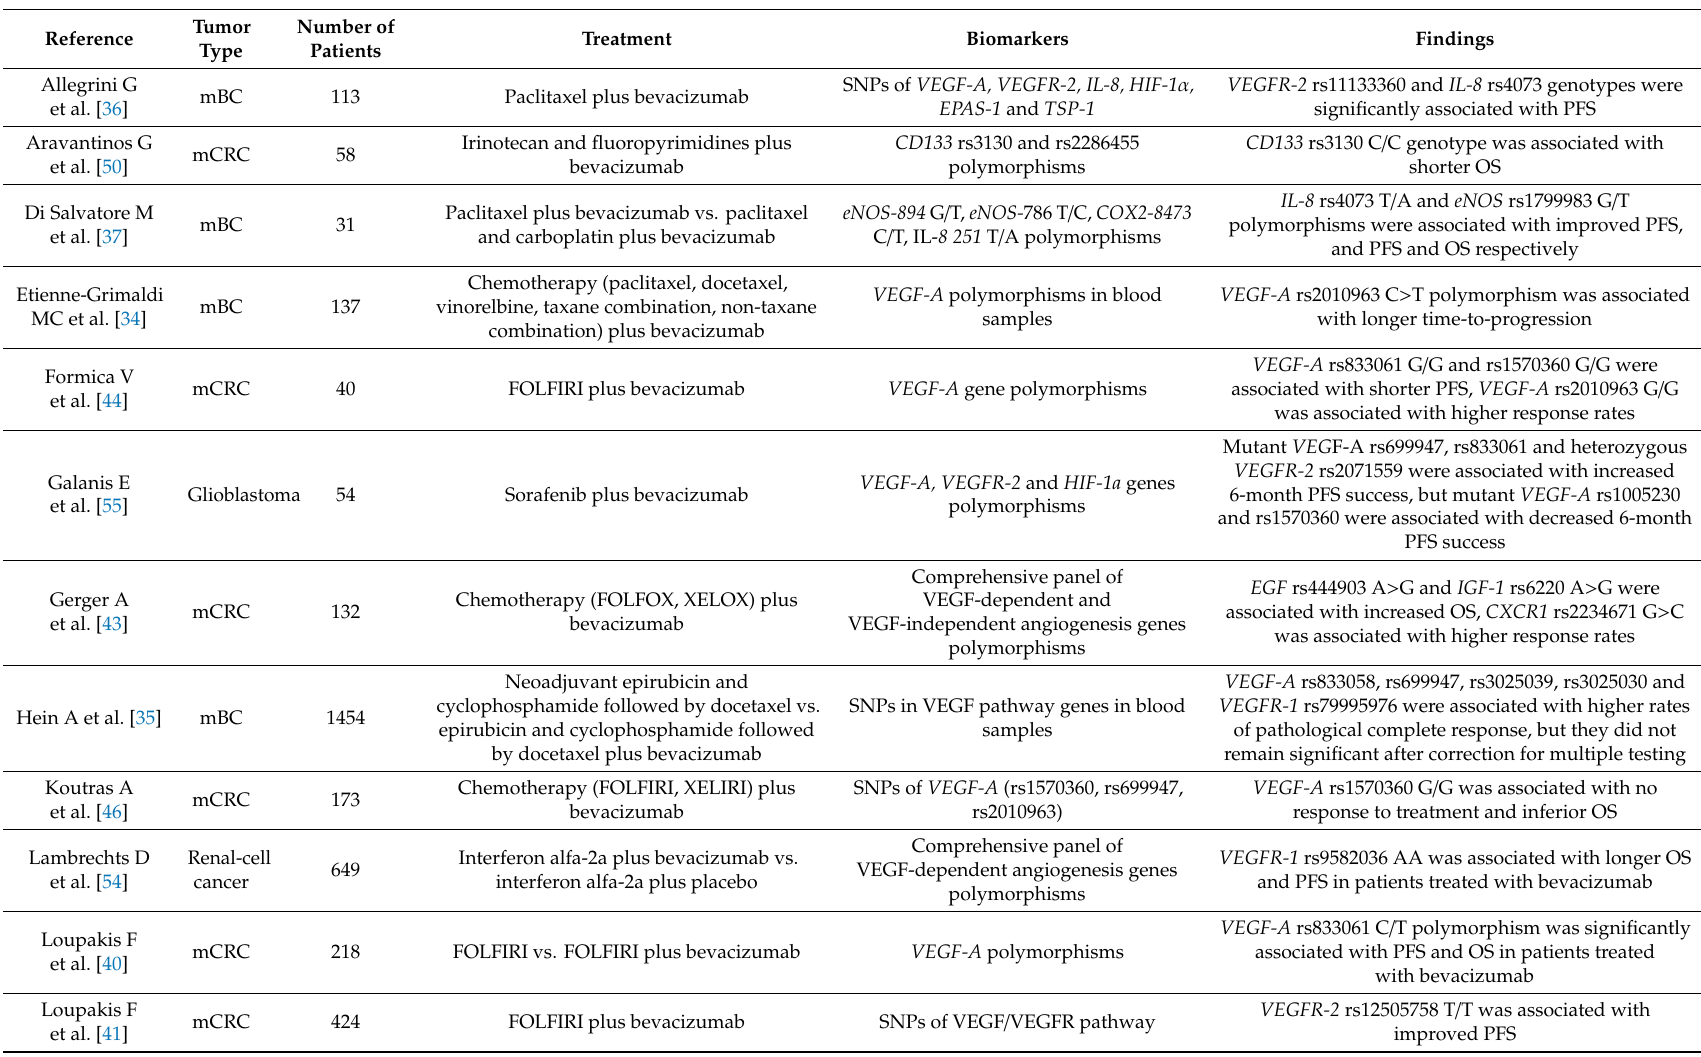
Table 2. Available studies on gene polymorphisms associated with response to